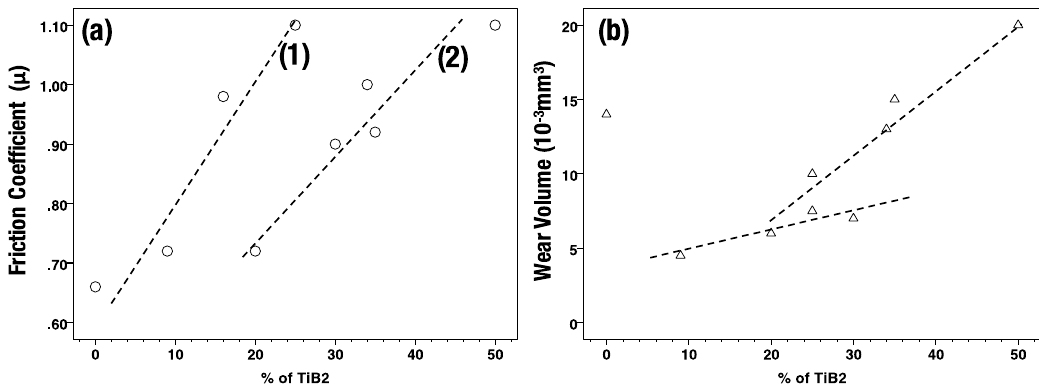
Figure 4. The measured CoF ( a ) and wear scar volumes ( b ) of TiAlN/TiB 2 multilayer coatings. There are two observed frictional coefficient regimes corresponding to a lower and higher rate of material loss, labelled (1) and (2). In regime (1), material loss occurs mainly via delamination between the layers; regime (2), material loss occurs via a break ‐ up of material into finer particles that in combination with the loads results in greater material loss.